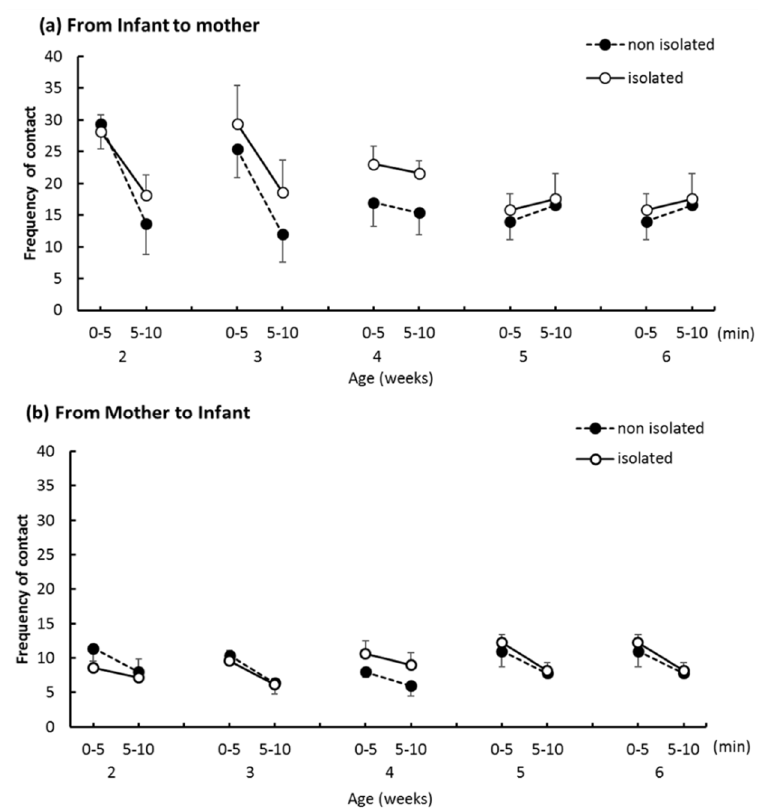
Figure 7. The mean frequency of contact initiated from infant to mother ( a ) and mother to infant ( b ). Error bars indicate the standard error.